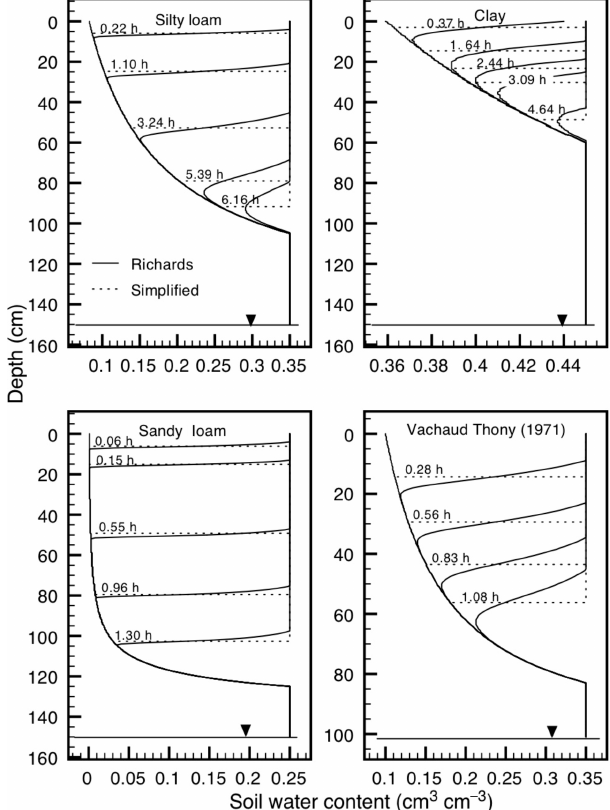
Figure 5. Comparison of soil water ( θ) redistribution be- tween Richards equation numerical solution (solid lines) and the SWINGO simplified model (dashed lines) during infiltration with- out initial ponding and with vertical drainage (Vachaud) bottom boundary condition ( f w ) for soils in Table